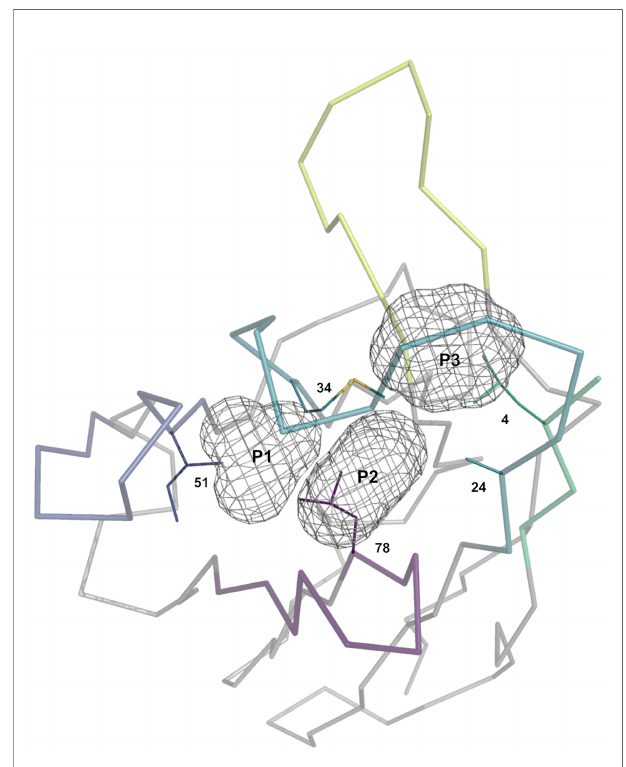
FIGURE 2 | Representation of the three pockets (P1, P2 and P3) situated in the vicinity of the CDR-H1 (turquoise), CDR-H2 (blue), CDR-H3 (lime) loops, a segment of FR3 (purple) and a segment of the N-terminal (green). The pockets form, together with its surrounding residues, the core region that requires to be packed to avoid exposing core hydrophobic residues (numbered residues shown as thin solid lines). The core residues shown are the most probable at those positions: Ile-4, Ala-24, Met-34, Ile-51 and